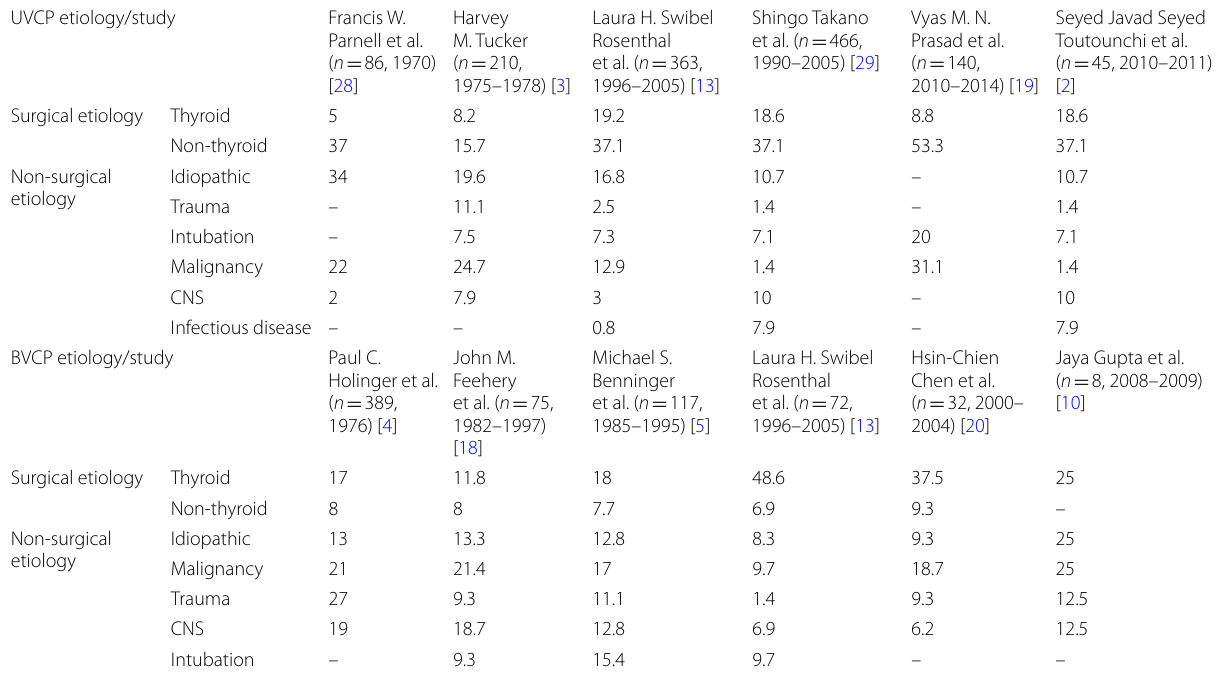
Note : All the figure mentioned in